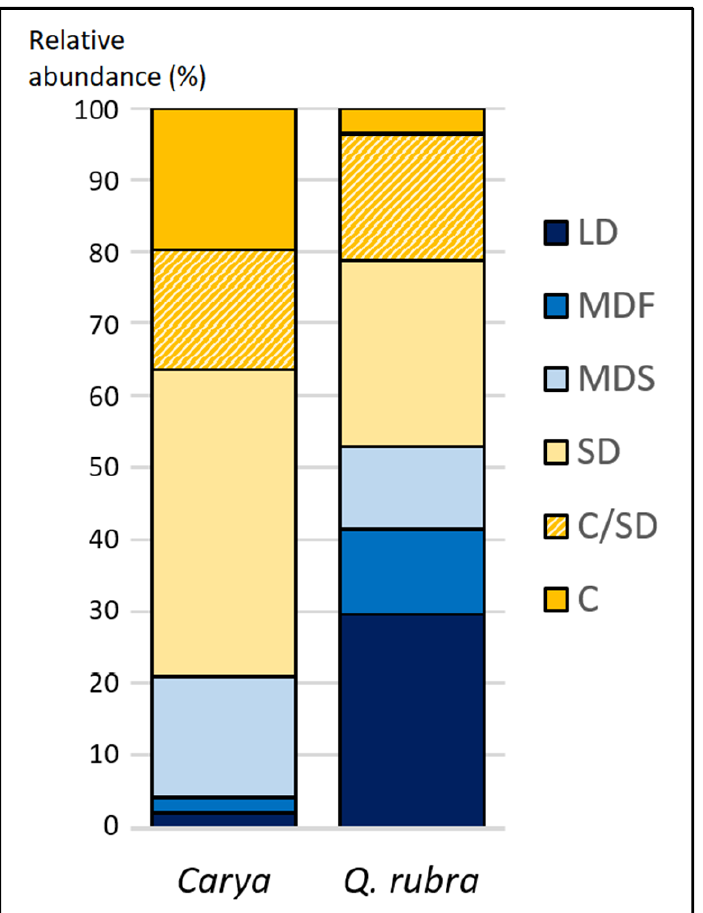
Figure 3. Relative abundance of exploration types of ectomycorrhizas on Carya and Q. rubra roots based on the classification proposed by Agerer [43]: C—contact, SD—short-distance, C/SD—contact or short distance; MDS—medium-distance smooth, MDF—medium-distance fringe, and LD—long- distance exploration